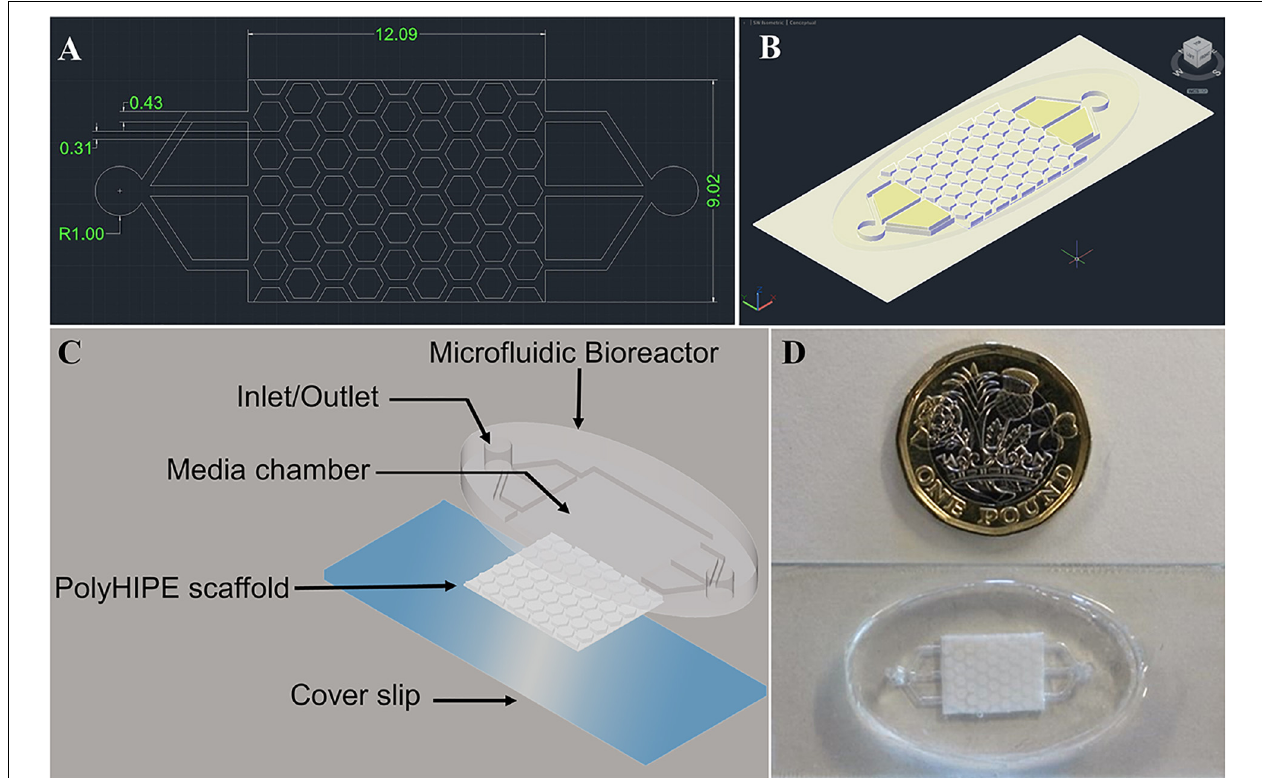
FIGURE 1 | AutoCAD design of the bone microfluidic chip (A) 2-D and (B) 3D view of the combined bioreactor and polyHIPE scaffold. Dimensions are in mm. (C) Schematic/exploded view of the chip components, including the microfluidic bioreactor, polyHIPE scaffold and a cover slip. (D) Photograph of the assembled chip with a £1 (GBP) coin for